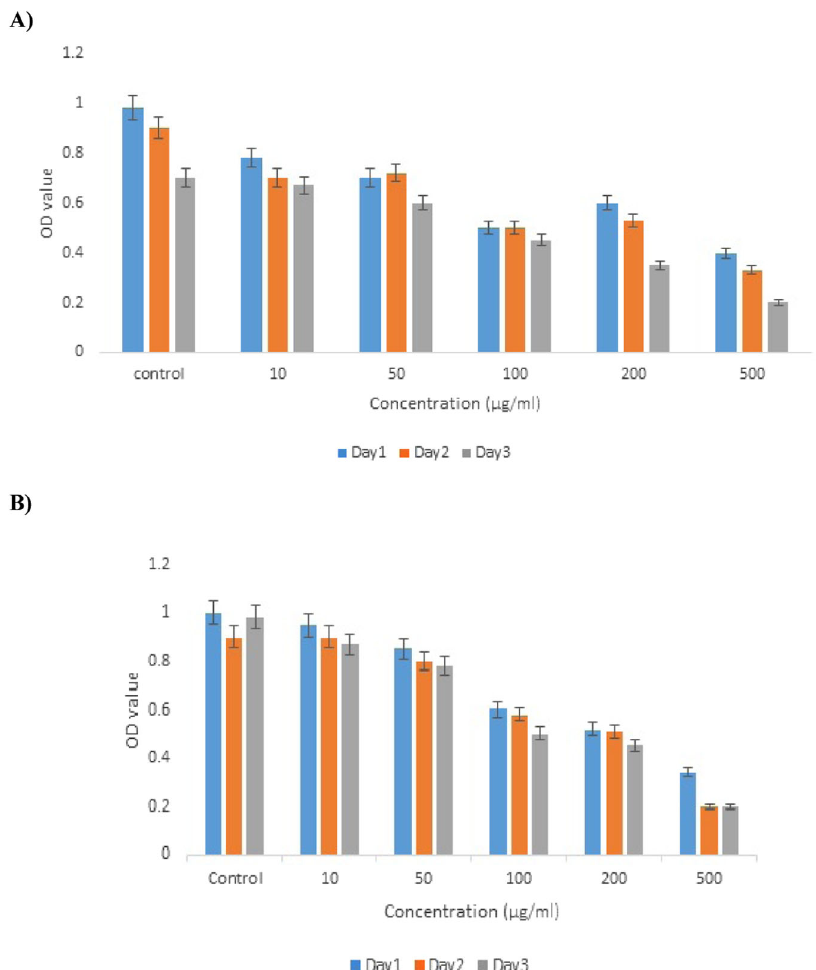
Fig. 4 The effects of TiO 2 NPs on the viability of rBMSCs and rATSCs determined by MTT assay after treating with (0 – 500 µg/ml) TiO 2 NPs for 1, 2, and 3 days in comparison to control group. A In the rBMSCs, the inhibitory concentration in half maximum (IC 50 ) was around 100 µg/ml TiO 2 NPs. B In the rATSCs, the inhibitory concentration in half maximum